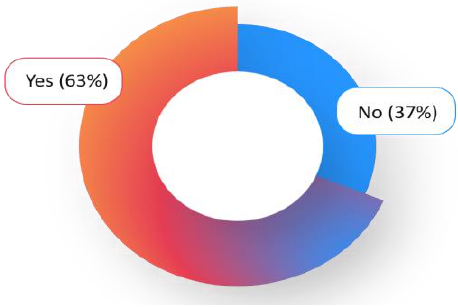
Figure 18. Classification by pre-processing techniques.